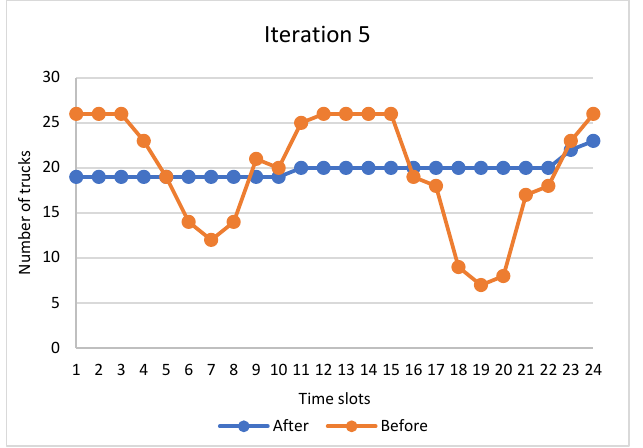
Figure 11. The workload before and after applying balancing constraint on iteration 5.